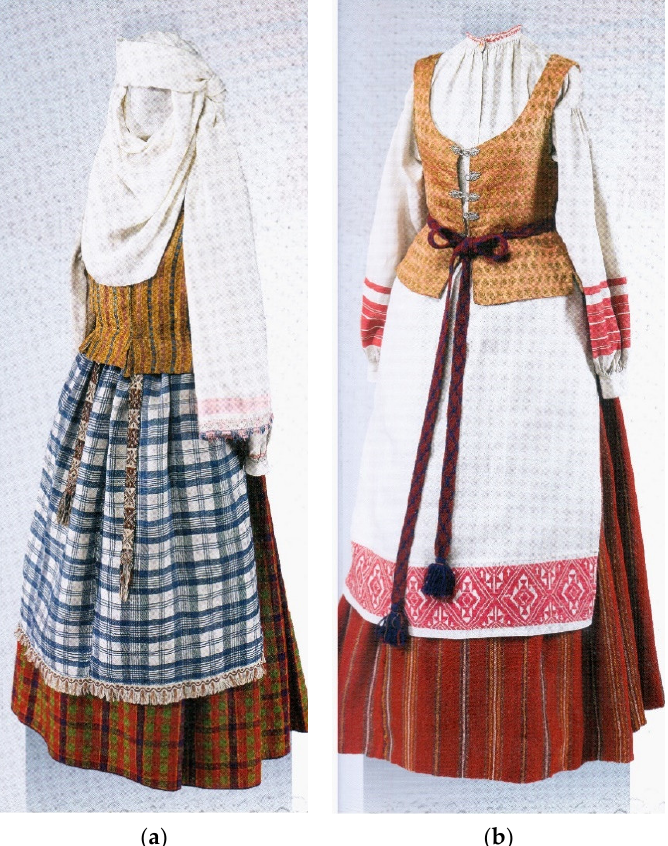
Figure 13. Folk costume from Aukštaitija: ( a ) From Rokiškis district; the 19th century; skirt LDM LA-1467; shirt LDM LA-1224; apron ČDM E-1038; vest ČDM E-1372; wimple LDM LA-1640; sash LDM LA-1521; ( b ) from Ignalina district, the second half of the 19th century: Skirt LDM LA-2333; shirt LDM LA-3778; apron LDM LA-3753; vest ČDM E-1368; sash LDM LA-3815. As shown in Figure 14, the marginalised national costume is similar, but differs from the folk clothes of the Aukštaitija region. The skirt is horizontally striped instead of checked or vertically striped. The crown and its sashes are also made from cotton instead of linen and silk. The colours are, moreover, brighter than those used in authentic folk costumes. The vest cut also differs. The bottom part of the vest is not folded, but instead sewn from many separate pentagonal segments. The chest is fastened with three narrow sashes.